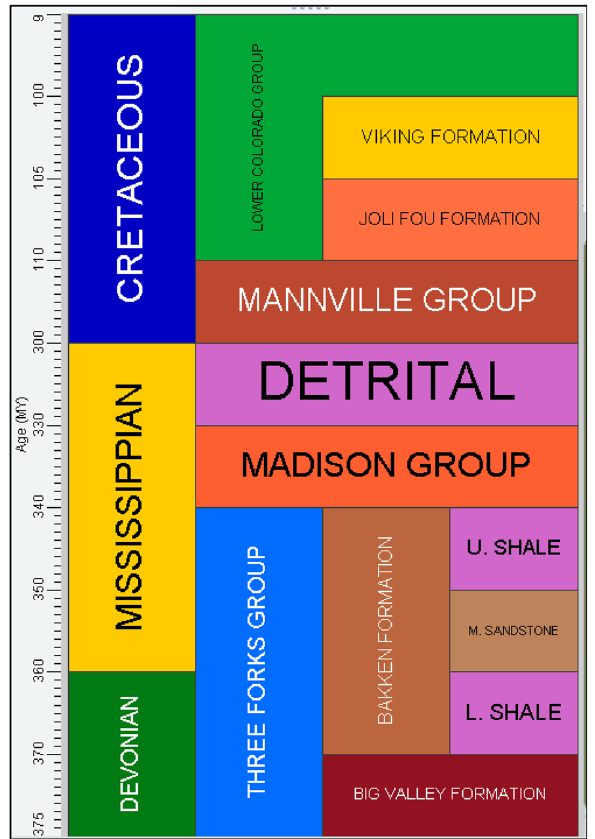
Fig. 3 Stratigraphic column of study